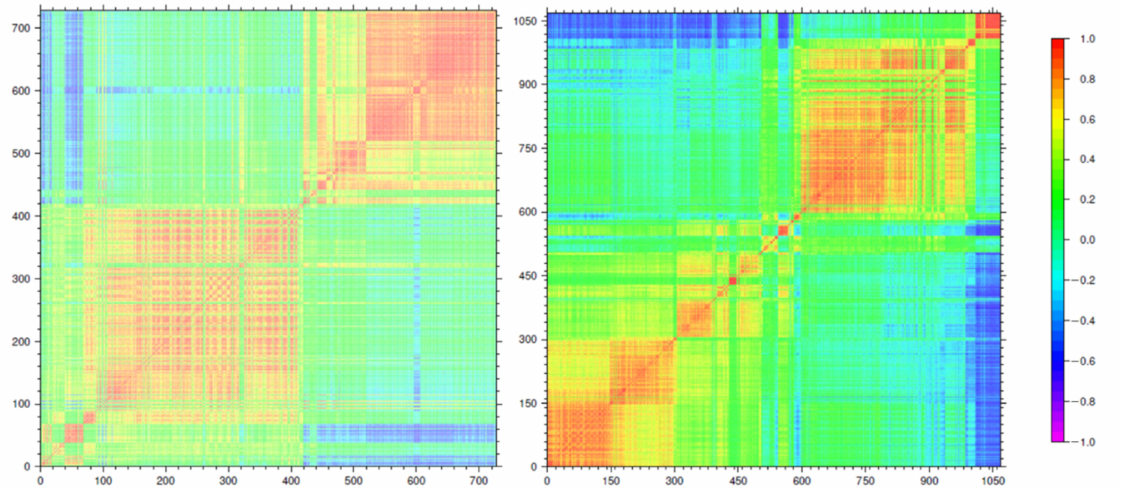
Figure 6. Cross-correlation matrix for ascending ( left ) and descending ( right ) orbits of the Santo Stefano d’Aveto case study. The X and Y axes show the number of PS, the colour scale indicates the similarity between each pair ( − 1 maximum uncorrelation; 0 different signals; 1 maximum correlation). In a first visual interpretation, if a threshold of 0.8 is considered, each orange-to-red square would represent a single PS Family. A variable number of PS Families can be recognised in descending and ascending orbits due to the different PS extrapolated during the processing and, most importantly, to the orientation of the landslide that, in this case, is better visualised by the descending